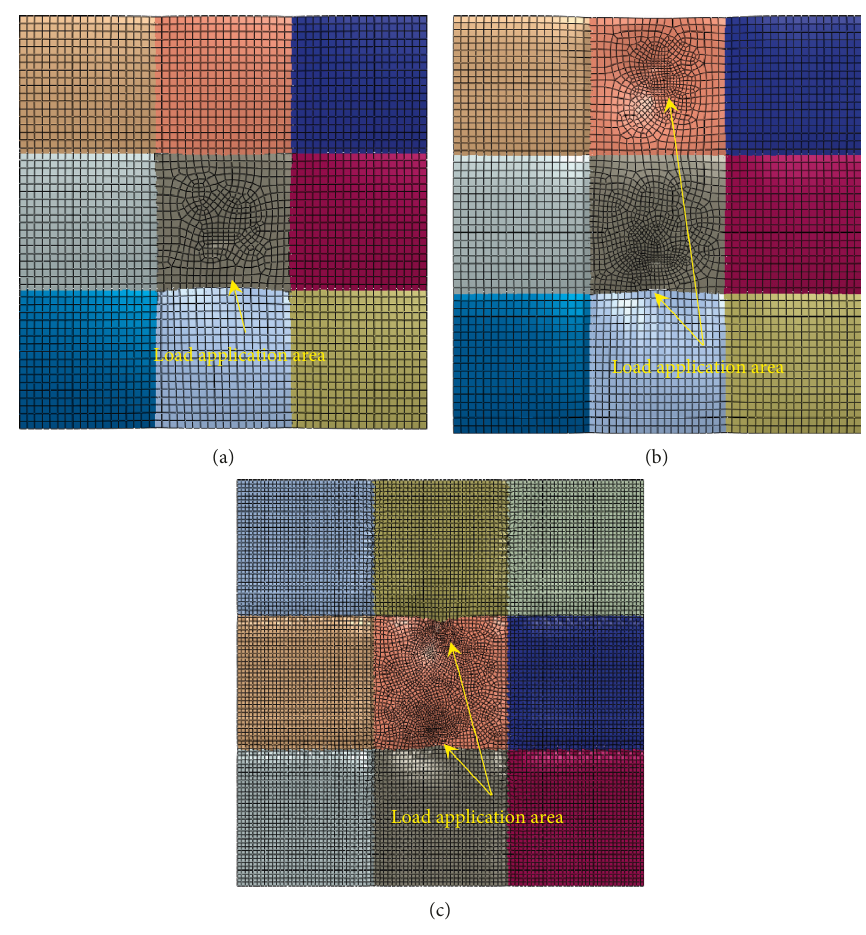
Figure 8: Distributions of the single axle dual wheel load on the concrete slabs with different sizes. (a) Load acting on separated slabs. (b) Load acting on adjacent slabs. (c) Load acting on a single slab. Table 5: Statistics of numerical